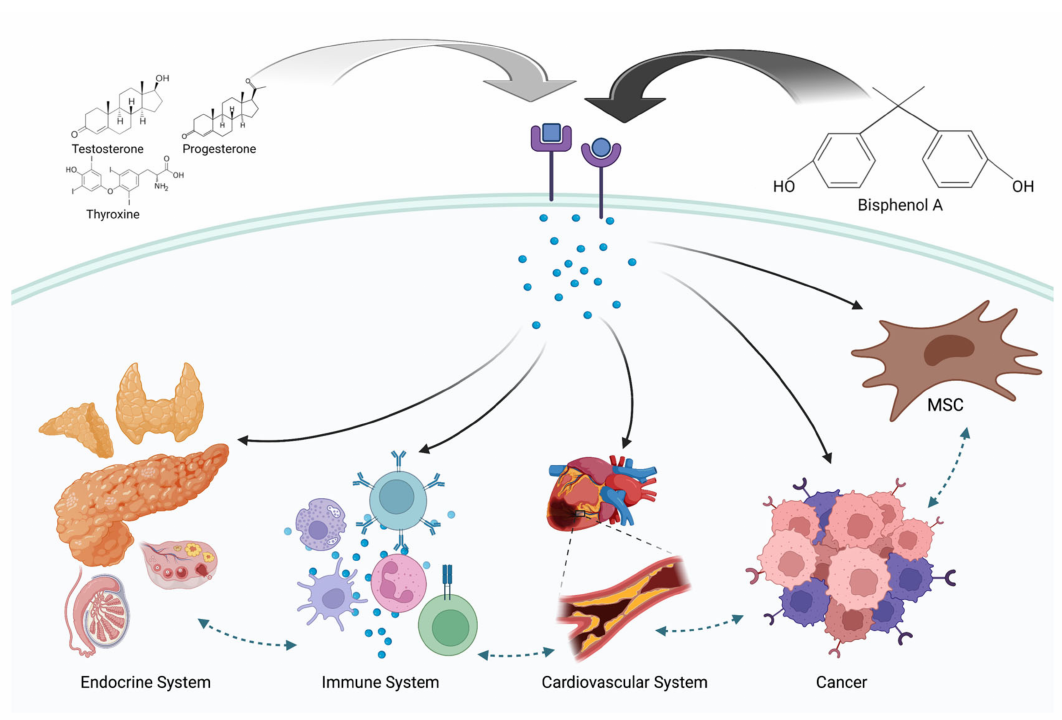
Figure 3. Schematic representation of the main targets for BPA in the human body, including MSCs (mesenchymal stem cells). Created with